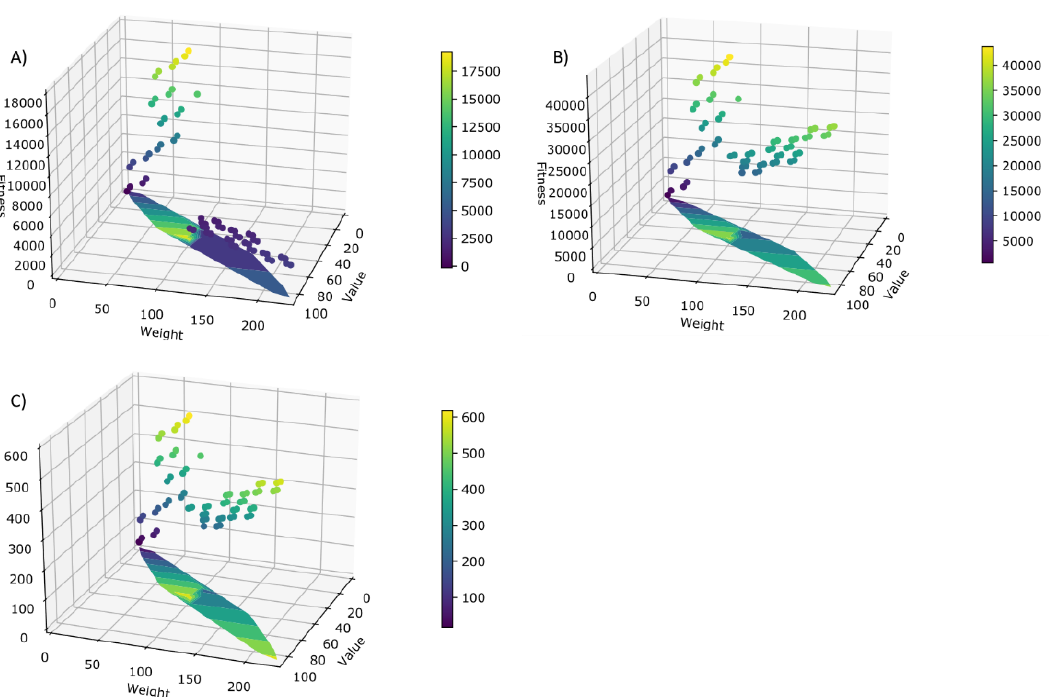
Figure 12. Spectra of solutions for the 0 / 1 knapsack problem solved with SGA genetic algorithm, evaluating fitness with ( A ) Lac operon screening procedure ( B ) antibiotic screening procedure and ( C ) chemotaxis screening procedure.